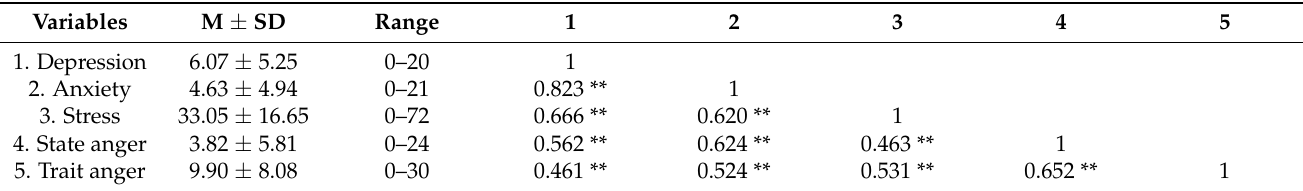
Table 2. Level and correlation among the main